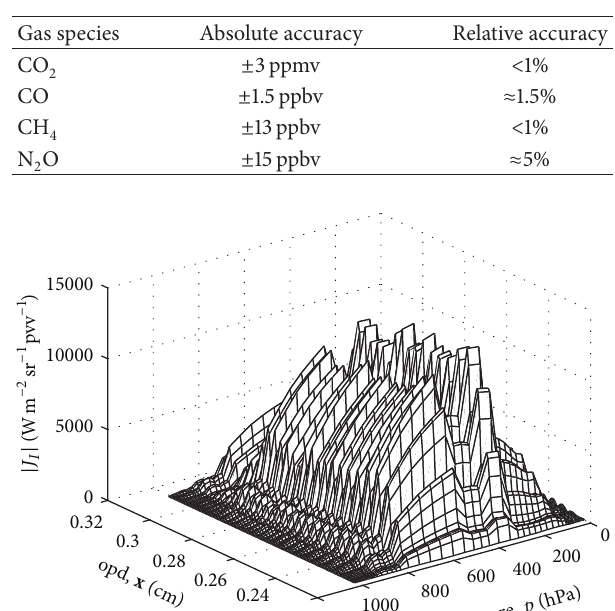
Table 1: Accuracy of the retrieved total columns of the trace and minor gases for a single IASI field of view.